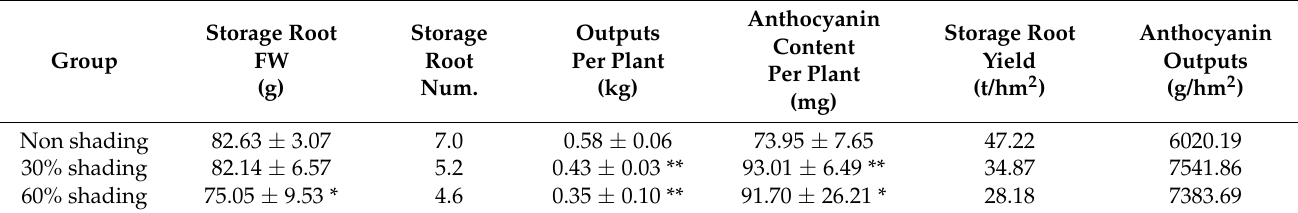
Storage Root FW: average weight of single sweet potato root (g); Storage Root Num.: average number of storage roots of single plant; The data of storage root yield and anthocyanin outputs have been obtained according to potted plant data determined. Data of storage root FW and outputs per plant are shown as means ± SD from 60 individual plants with more than two storage roots per plant (n = 120) in each group during 2017–2019. Data of anthocyanin content per plant are shown as means ± SD from nine individual plants with main storage roots mixed per plant (nine biological replicates, n = 9). The asterisk represents a significant difference compared to non-shading group (*, p < 0.05; **, p < 0.01). PSP, purple-fleshed sweet